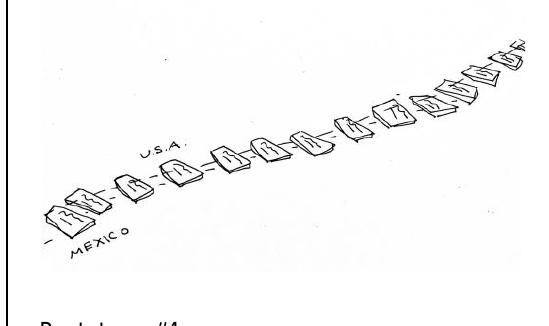
Figure 6 J. M. Design Studio, “Prototype #4 A Wall of Gravestones for Migrants And Refugees (Memorial to Asylum)” from The Other Border Wall Proposals (2017). Digital scanned image of ink drawing on paper, text. 8 ½ X 11 inches. Collection of J. M. Design Studio.